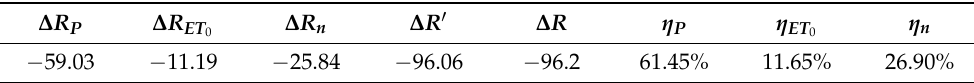
Table 6. Contributions of underlying surface and climatic factors to the changes in runoff during the study period.